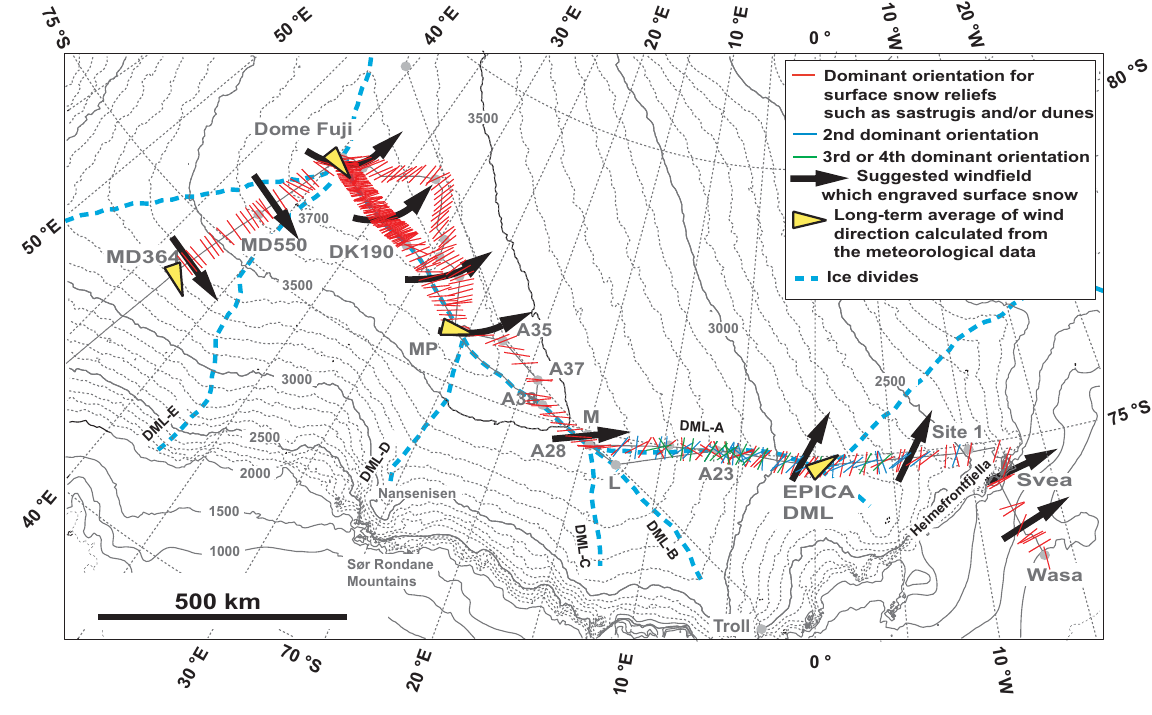
Fig. 5. Dominant orientation of surface snow reliefs such as sastrugis and dunes observed along the traverse routes between MD364 and Wasa. Orientations are plotted as thin lines on the map. At some sites, two or more orientations were observed, in particular at sites between A28 and A23. The dominant orientation is shown as red symbol markers. The second and lesser orientations are shown as green and blue markers, respectively. Thick black arrows are the suggested directions of the strong winds ( > ∼ 10ms − 1 ) that caused the surface snow reliefs. Yellow arrows represent the orientation of the average wind field at MD364, DF, MP and EPICA DML, calculated from the meteorological data. For MD364, DF and MP, the yellow arrows show the directions of the average wind vectors. Details are given in Table 4. At EPICA DML, the yellow arrow represents the long-term average wind direction (Birnbaum et al., 2010; Reijmer and Van den Broeke, 2003). Bold blue dashed curves indicate ice